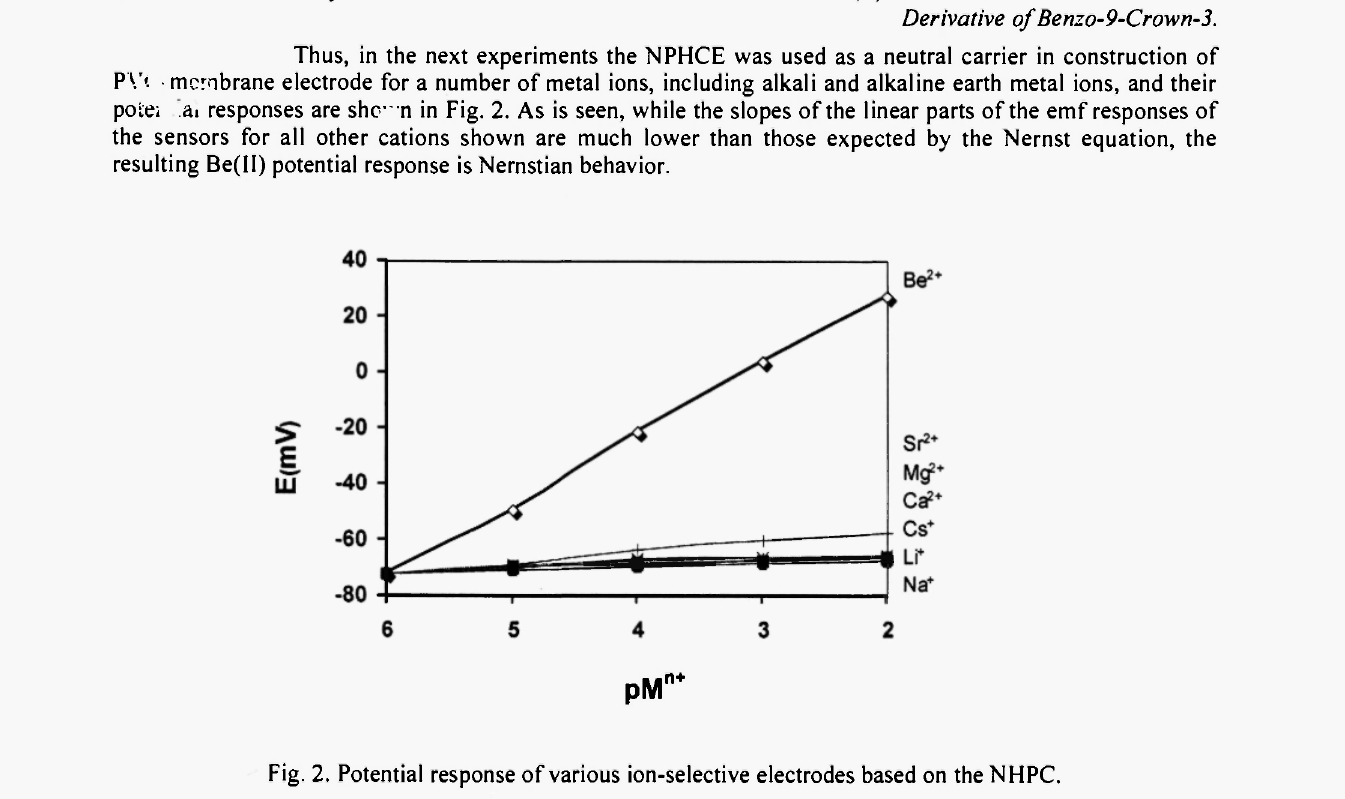
Fig. 2. Potential response of various ion-selective electrodes based on the